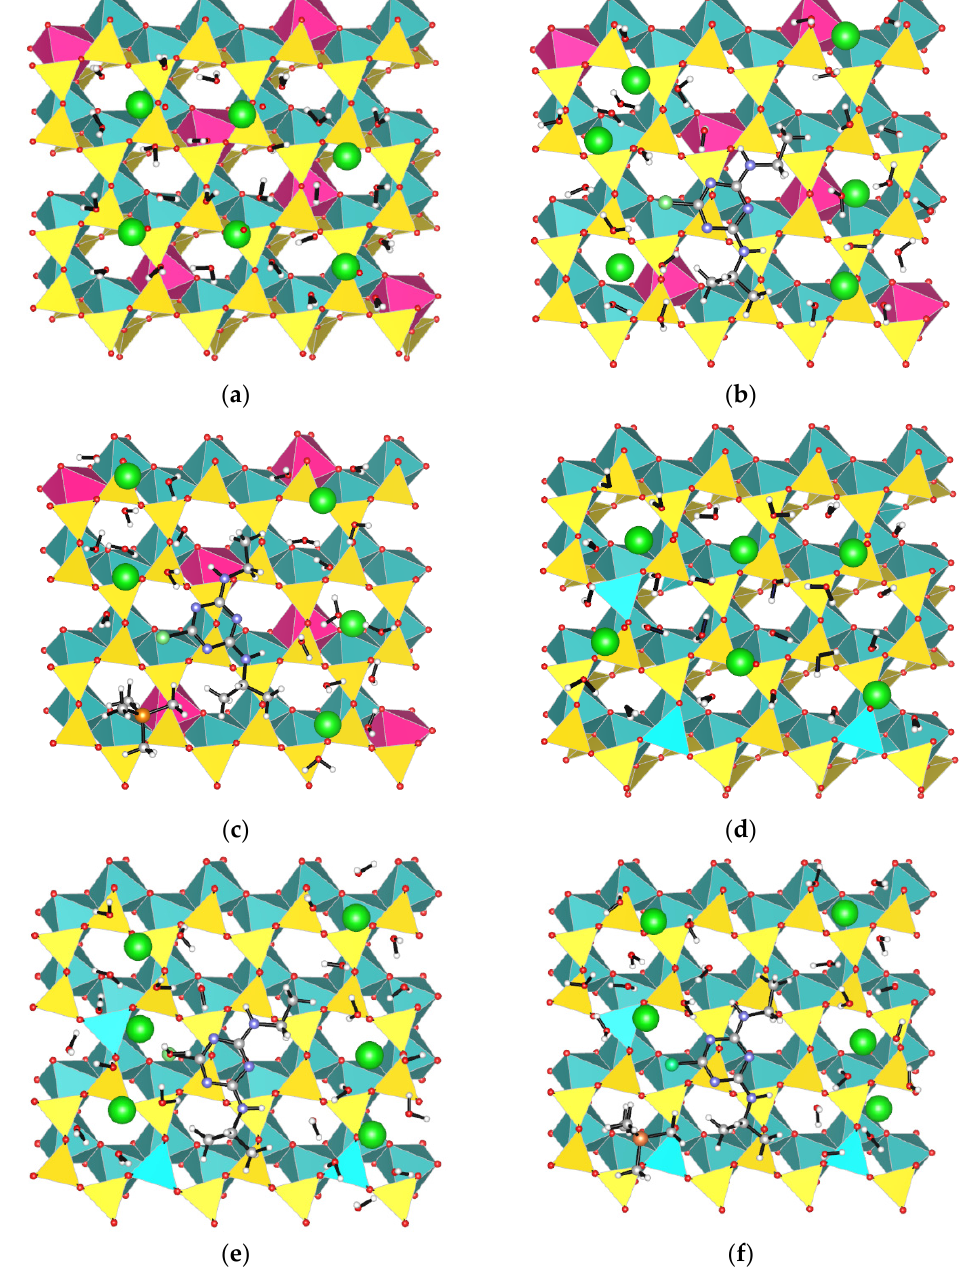
Figure 1. Interlayer space arrangement from c -view of: Na-Mt ( a ); A-Mt ( b ); A-TMP-Mt ( c ); Na-Bd ( d ); A-Bd ( e ); and A-TMP-Bd ( f ). The Si 4+ tetrahedra are in yellow, the Al 3+ tetrahedra and octahedra are in cyan and the Mg 2+ octahedra are in magenta.